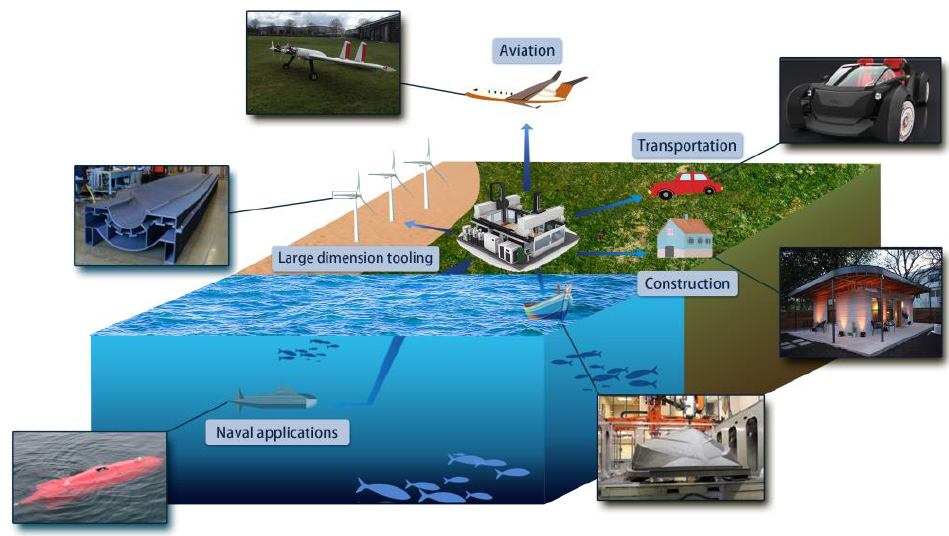
Figure 1. Widespread LAAM-produced composites’ applications in different engineering fields.